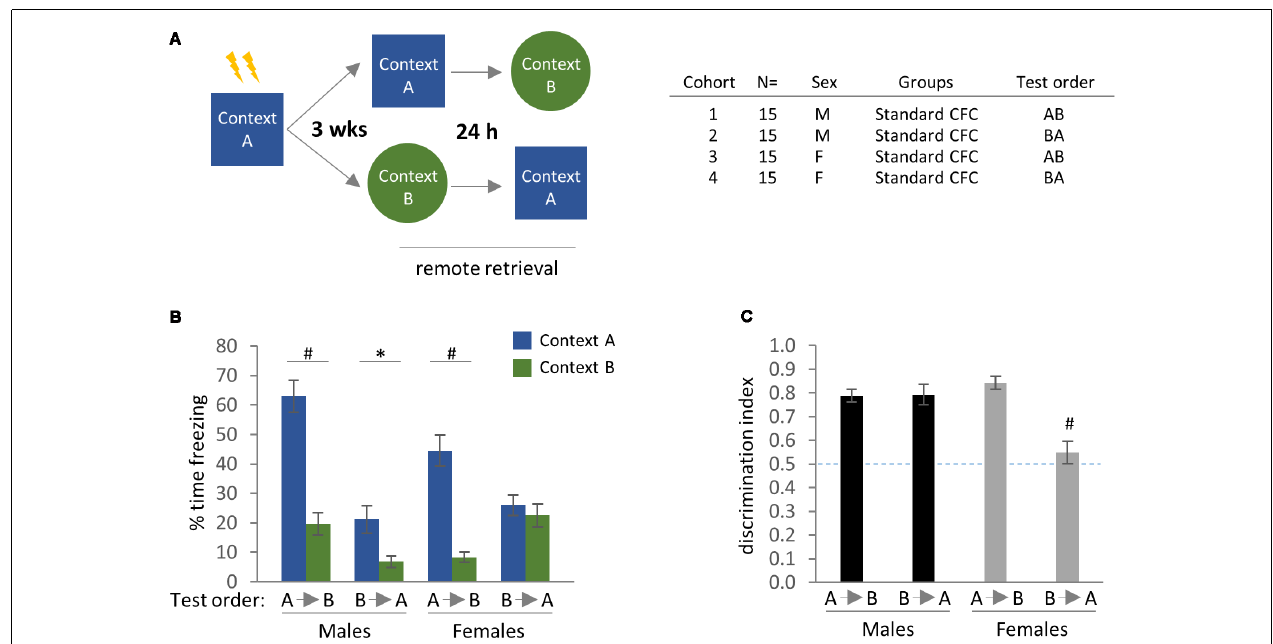
FIGURE 2 | Remote contextual fear memory and generalization with perceptually distinct training and generalization contexts (Contexts A and B, respectively). (A) Experimental design and cohort information. (B) Effect of test order on freezing behavior in the training context (Context A) vs. a distinct novel context (Context B) at 3 weeks after standard contextual fear conditioning (CFC). Bonferroni post hoc comparisons following three-way analysis of variance (ANOVA) are indicated. (C) Discrimination index, calculated as % Freezing in Context A/(% Freezing in Context A + % Freezing in Context B). # p < 0.0001 for effect of test order in